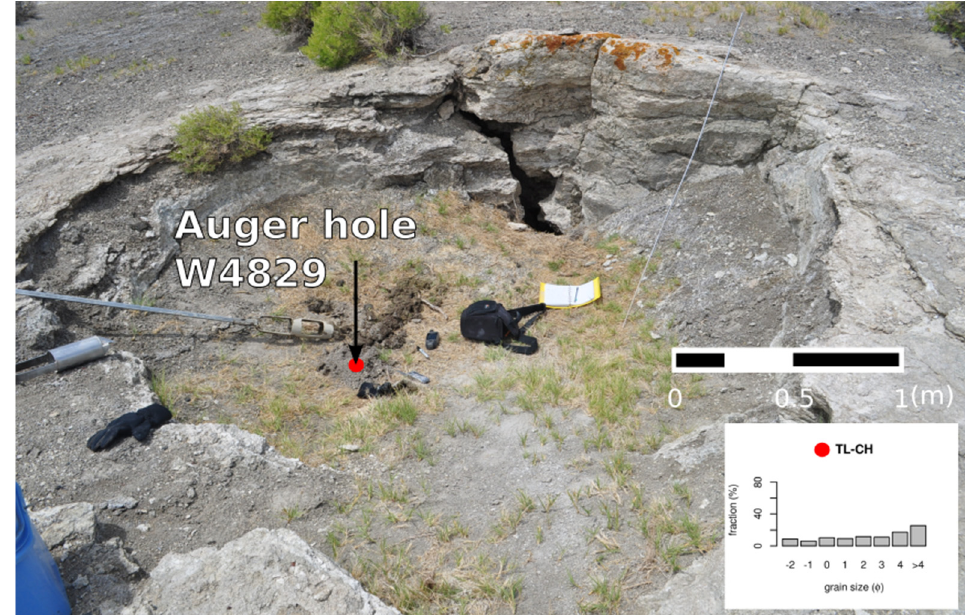
Figure 14. Image looking north at feature Q12, location of TL sample W4829. The fracture in the sinter is oriented N/NE and continuation is indicated by the linear orientation of bushes in the image. The grain size chart is shown for sample TL ‐ CH, which was collected immediately above the TL sample depth of 27 cm.